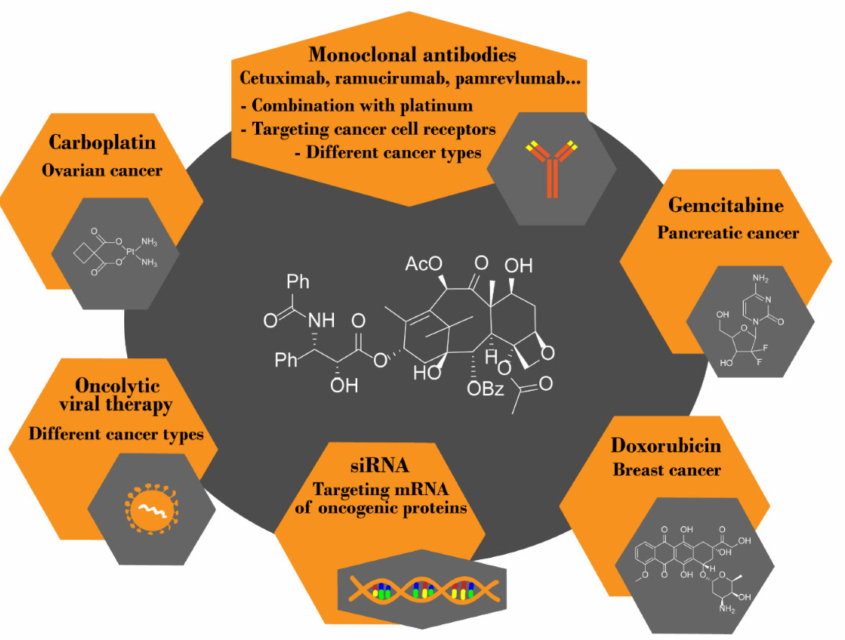
Figure 9. Chemical structure of paclitaxel, diverse approaches of combinatorial treatment with paclitaxel, and indications for particular drug